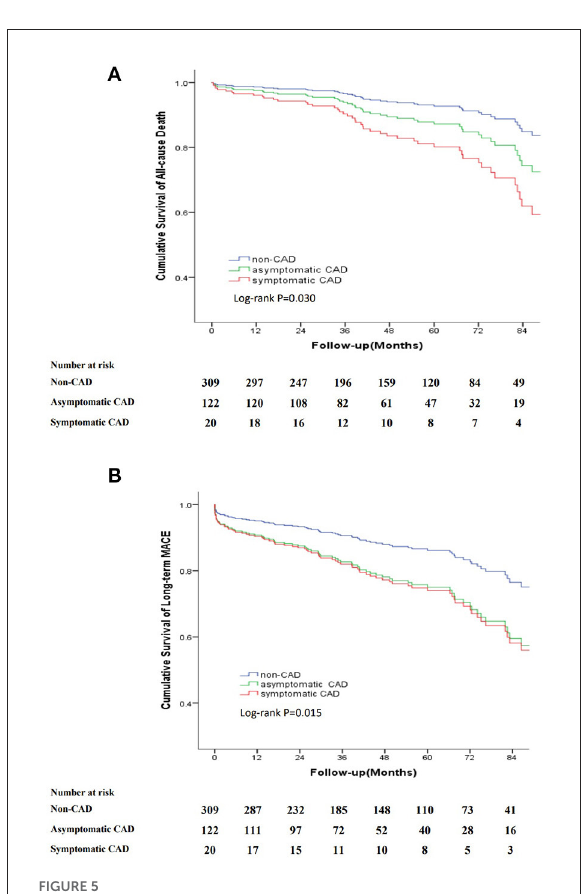
FIGURE5 Kaplan-Meier curve for cumulative survival rates of long-term mortality and long-term MACE classified by non-CAD, asymptomatic CAD and symptomatic CAD. (A) Kaplan-Meier curve for cumulative survival rates of long-term mortality. (B) Kaplan-Meier curve for cumulative survival rates of long-term